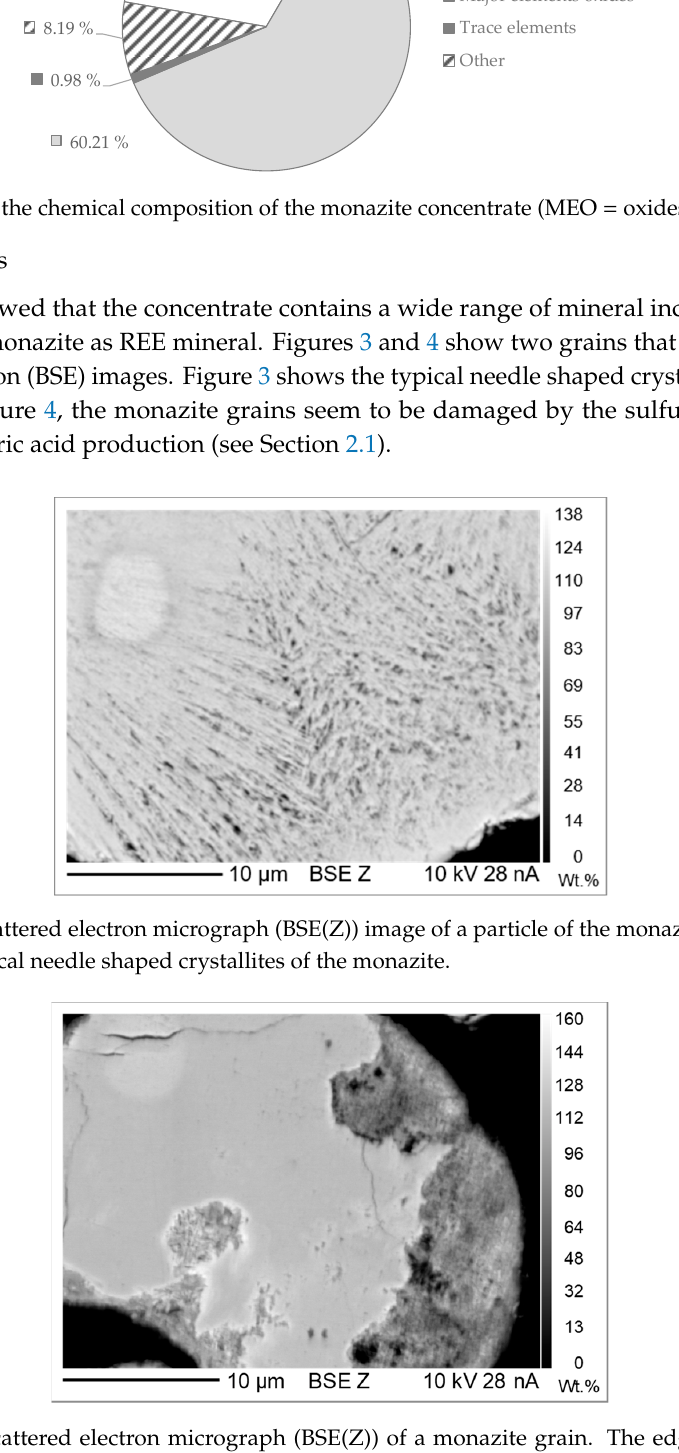
Table 2. Average composition of the monazite in the concentrate measured by electron microprobe analysis compared to the typical composition of a monazite standard reference [25]. Elements